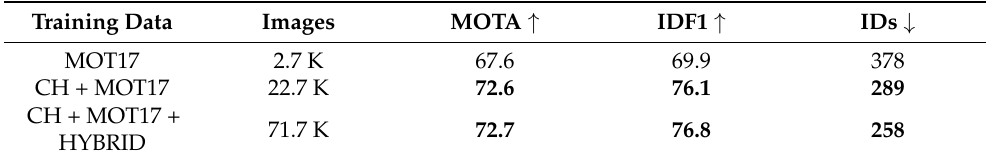
Table 7. Comparison of different training data on the MOT17 validation set. “MOT17” is short for the MOT17 half-training set. “CH” is short for the CrowdHuman dataset. “HYBRID” represents the large-scale training dataset described in Datasets . The best results are shown in bold